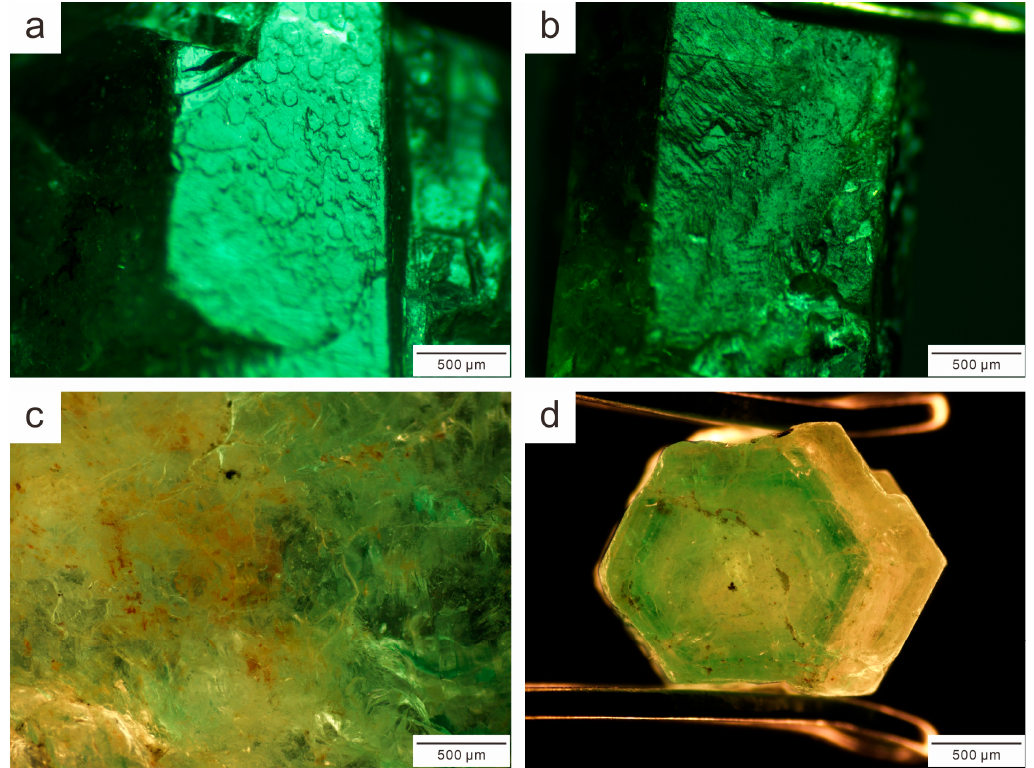
Figure 3. ( a ) Round growth hillocks on the surface of emerald column (KAM-1); ( b ) Etchpits on the surface of emerald column (KAM-45); ( c ) Red Fe oxide impurities on the surface of emerald (KAM-14); ( d ) Hexagonal color zones in emerald (KAM-9). The emeralds from Kamakanga had a refractive index of 1.585–1.602 (n e : 1.585–1.593 Table 1. Gemological properties of emeralds from Kamakanga, Zambia. and n o : 1.592–1.602) with birefringence between 0.007 and 0.009, and specific gravity of 2.74–2.81. Turning emerald samples 360 ◦ under a polariscope, the emeralds appear four times bright and four times dark. Dichroism was medium light green or green (o-ray) and bluish green (e-ray). The visible spectra of most emeralds from the spectroscope had distinct lines in the red region (approximately 680 nm), partial absorption in the orange and yellow region (between 580 and 620 nm), and complete absorption in the violet region (<460 nm). Through the Chelsea filter, all the emeralds appeared dark green. The emeralds were typically inert to long- and short-wave UV radiation. The gemological properties of emeralds from Kamakanga are summarized in Table